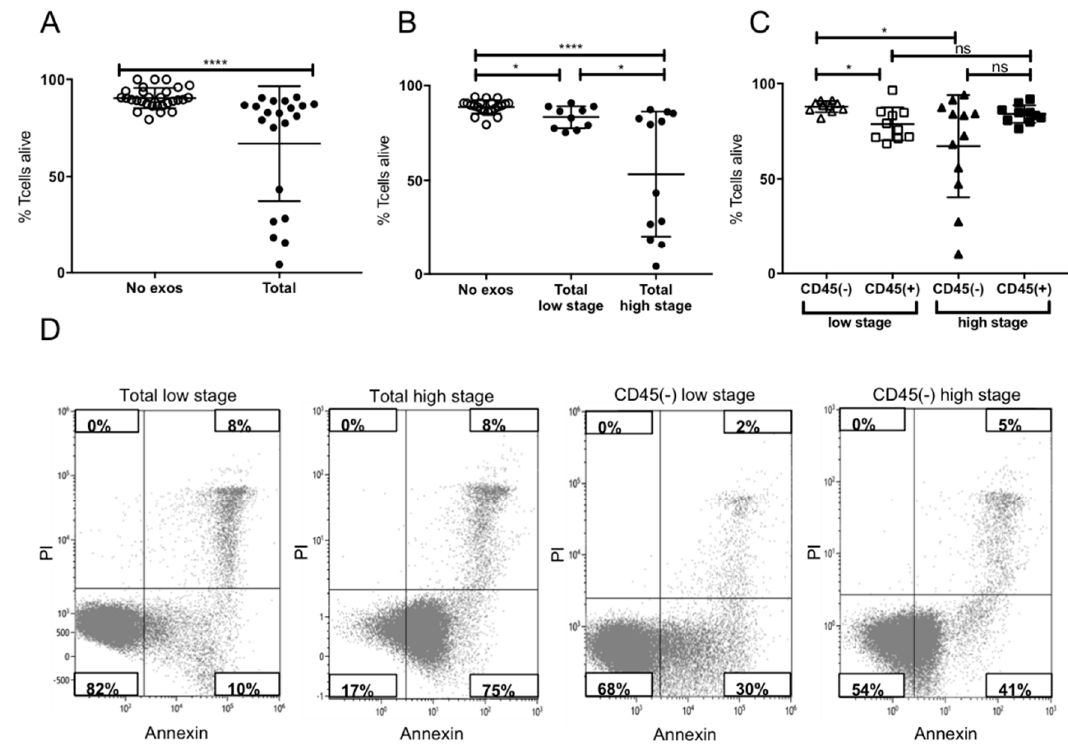
Figure 3. Induction of apoptosis in activated CD8 + T cells. ( A ) Induction of apoptosis after incubation with total exosome fractions. ( B ) Induction of apoptosis after incubation with total exosomes of low stage vs. high stage patients. ( C ) Levels of apoptosis after co-incubation with CD45( − ) or CD45( + ) exosomes of low or high stage patients. Note that only CD45( − ) exosomes induced stage-dependent apoptosis, whereas CD45( + ) exosomes showed no significant di ff erence between stages. CD45 ( + ) exosomes of low stage patients induced more apoptosis than CD45( − ) exosomes, whereas no significant di ff erence was visible between those of high stage patients; n = 29. p values were determined with Mann-Whitney test, with * p < 0.05, **** p < 0.0001. Bars represent mean with standard deviation (SD). ( D ) Representative flow cytometry plots depicting CD8 + T cells stained with Annexin / Propidium Iodide (PI) after incubation with total and CD45( − ) exosomes of Union for International Cancer Control (UICC) low or high stage